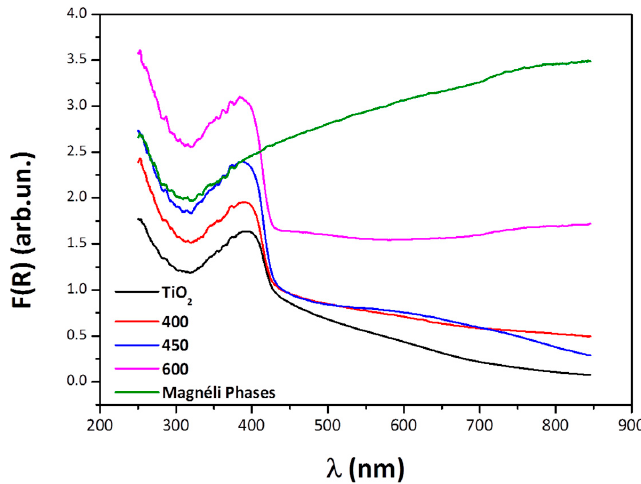
Figure 5. Diffuse reflectance spectra for rutile and reduced samples.